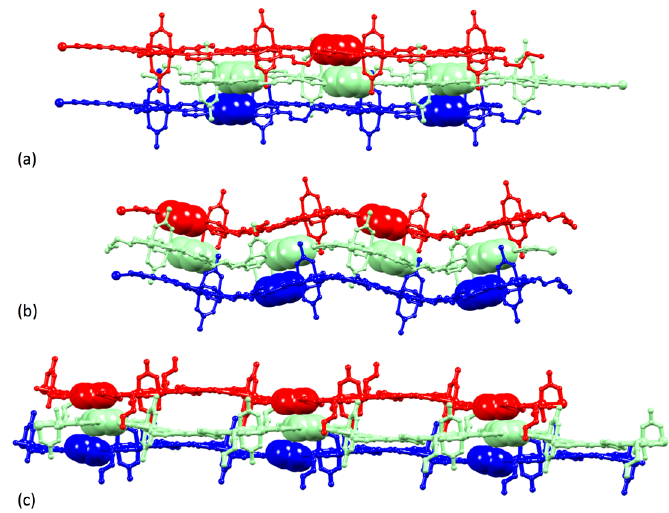
Figure 15. Packing of three adjacent 2D sheets (each comprising 1D polymer chains) in ( a ) [2{Cu 2 ( µ -OAc) 4 ( 2 )} · 1.25MeOH] n , ( b ) [Cu 2 ( µ -OAc) 4 ( 3 )] n and ( c ) [{Cu 2 ( µ -OAc) 4 ( 4 )} · 0.2CHCl 3 ] n . Solvent molecules and H atoms are omitted.